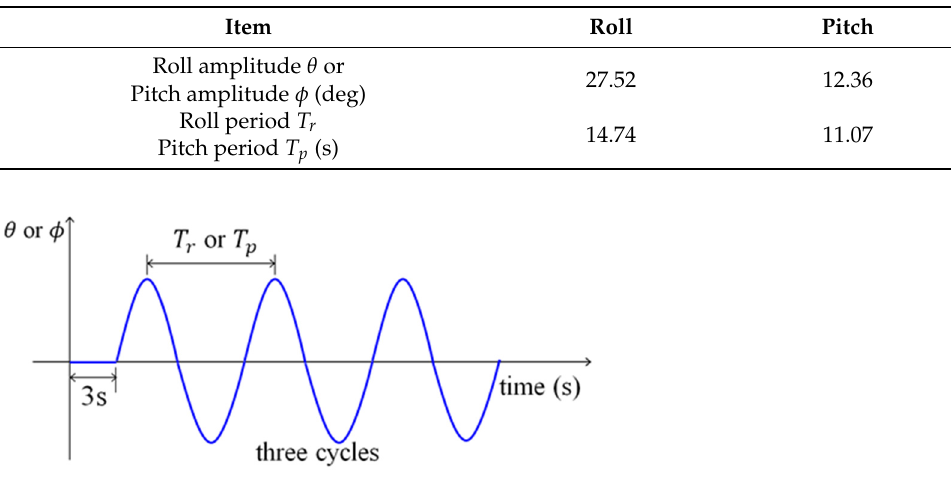
Figure 7. Sinusoidal roll and pitch motions.